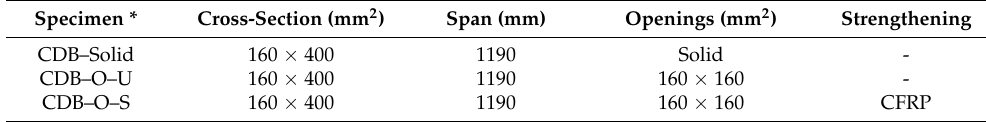
Table 1. Details of the tested specimens.